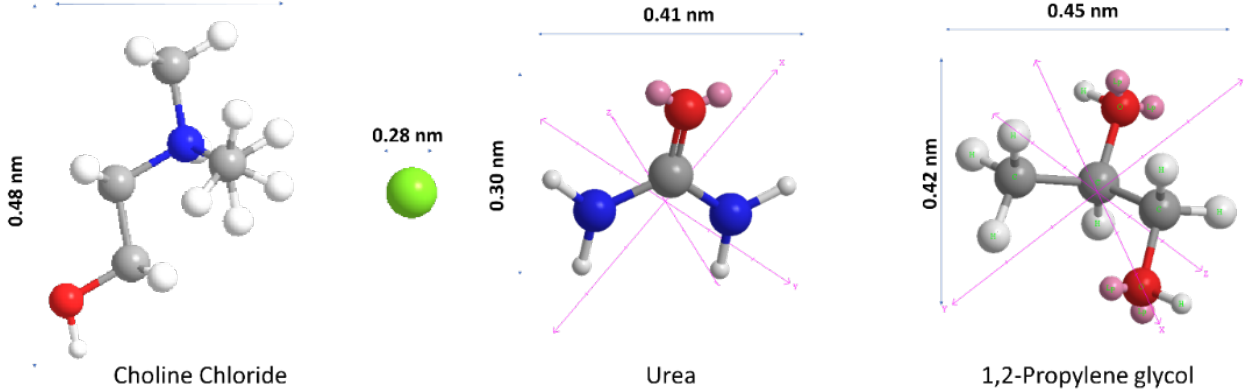
Figure 1. Approximate dimensions of DES components (choline chloride and HBDs). Atoms: C (gray), N (blue), O (red), and H (white). Molecules were drawn in ChemDraw19 software. Dimensions reported in [22,50].